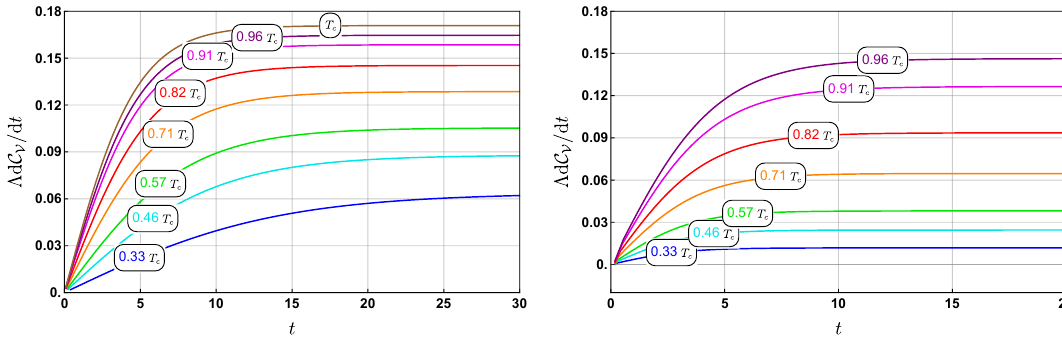
Figure 20 . The complexity growth rate of CV conjecture for the normal phase (left) and the superconducting phase (right) at different temperatures. The complexcity growth rate of the superconducting phase is smaller than the normal phase below the critical temperature. Here Λ = 10 G Ω and µ = 1 N L/ 2